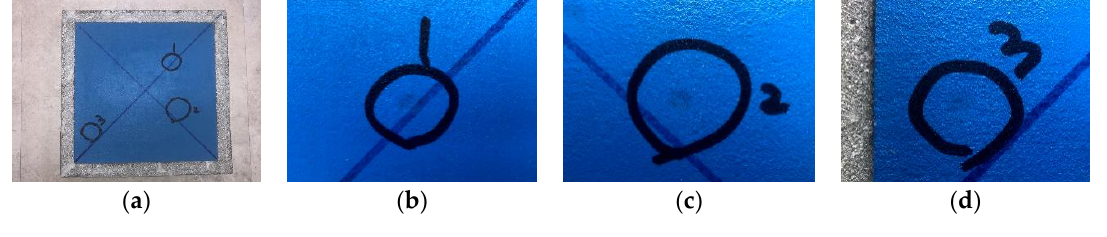
Figure 7. Adhesion strength.